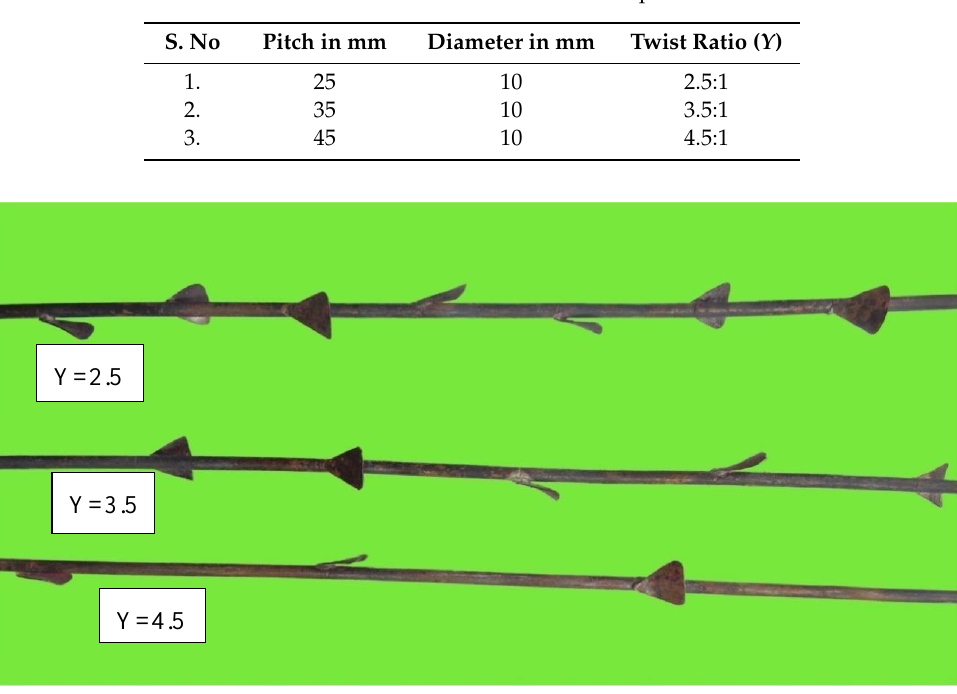
Energies 2020 , 13 , x FOR PEER REVIEW Figure 5. Photographic view of the staggered conical strip insert with Y = 2.5, 3.5, and 4.5. Table 2. Technical details of the conical strip inserts.